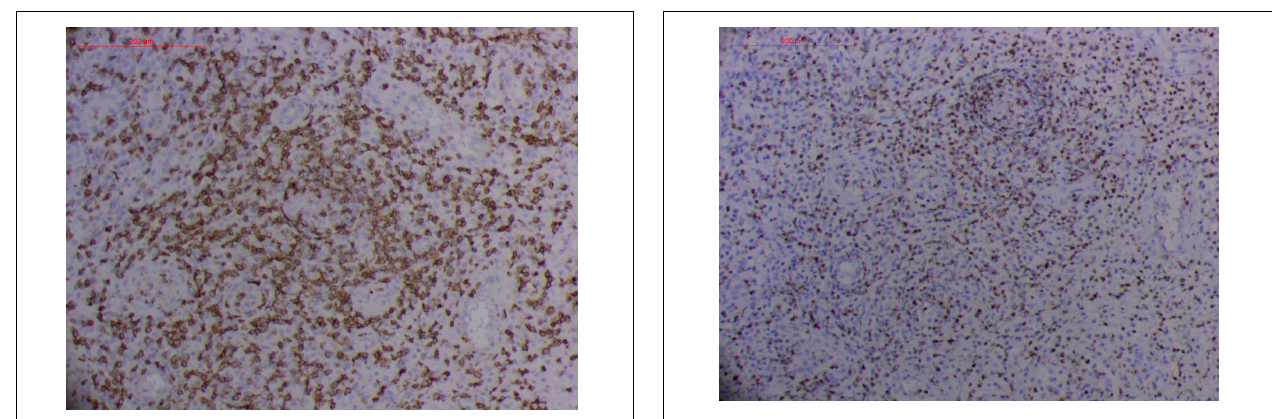
FIGURE 13 | Extranodal natural killer/T cell lymphoma, nasal type-orbital-cerebral mycosis.” Rhizopus arrhizus -induced positive expression of GZMB from granulomatous tissues (envision method, original magnification × 200).